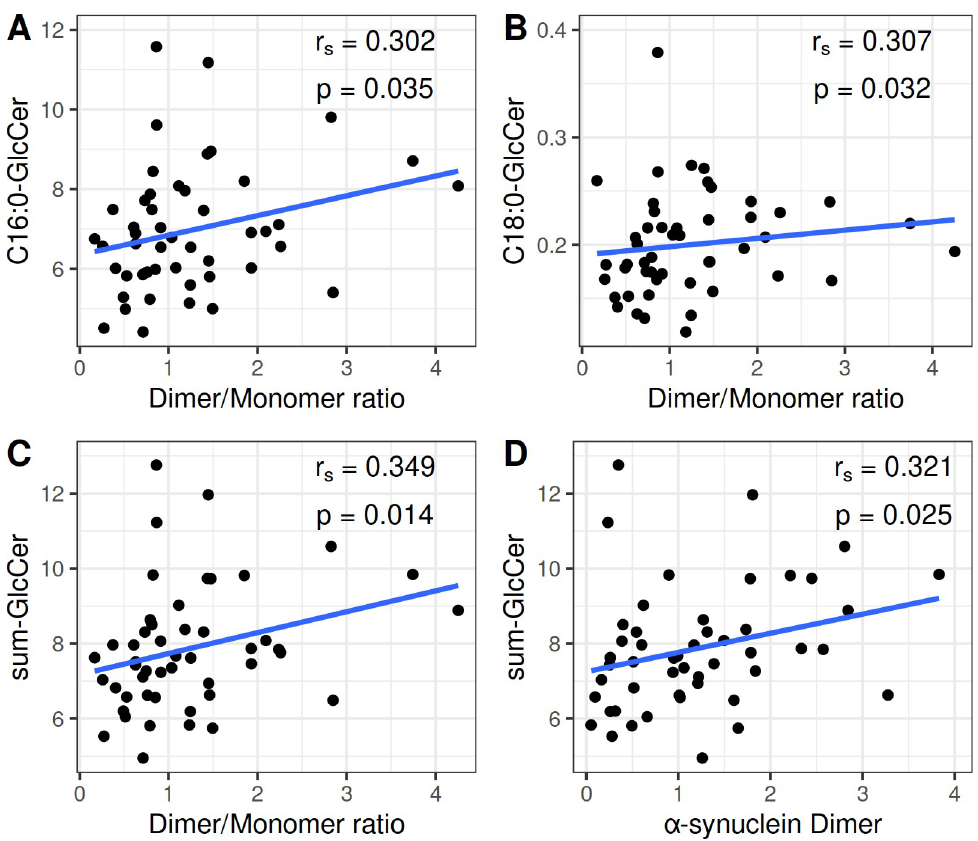
Fig 5. Statistically significant correlations between the α -Synuclein species and the lipids studied in controls. Correlation between (A) the α -Synuclein dimer/monomer ratio and N-palmitoyl-glucosylceramide (C16:0-GlcCer), (B) the α -Synuclein dimer/monomer ratio and N-stearoyl-glucosylceramide (C18:0-GlcCer), (C) the α -Synuclein dimer/ monomer ratio and the sum of glucosylceramide species (sum-GlcCer), (D) the α -Synuclein dimer and the sum of glucosylceramide species (sum-GlcCer). C16:0-GlcCer, C18:0-GlcCer and sum-GlcCer are expressed in pmoles/10 8 cells. The α -synuclein dimer is expressed as the ratio of dimeric α -Syn to GAPDH. The α -synuclein dimer/monomer ratio is expressed as the ratio of dimeric to monomeric α